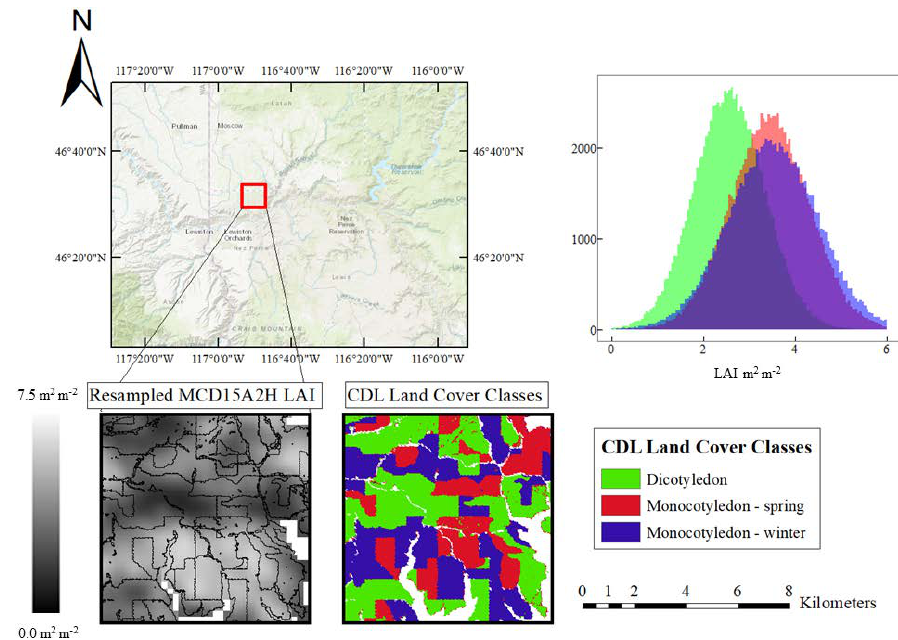
Figure 7. Extraction of LAI pdf for each crop type (upper right), obtained by combining the resampled MCD15A2H product from June 1st, 2016 (lower left) and the aggregated CDL product from 2016 (lower right). The resampled MCD15A2H was masked to exclude any area not been identified as cropland by the USDA CDL